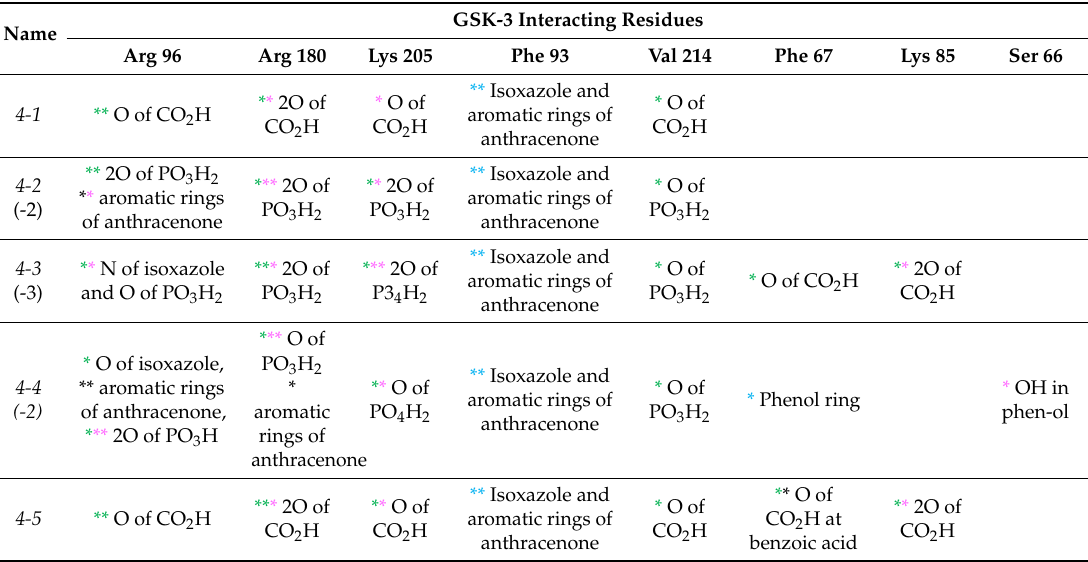
Figure 5. Docking new GSK-3 SCI molecules in GSK-3 substrate binding site. Docking models of GSK-3 β bound to 4-2 , 4-3 and 4-4 . Detailed interactions are also summarized in Table 2. Like 3-8 and the other leading hits, the new molecules interacted with the GSK-3 phosphate-binding pocket, Phe 93 and Val 214. 4-3 and 4-4 showed additional interactions with Phe 67, Ly 85 ( 4-3 ), or, Ser 66 ( 4-4 ). Interactions were analyzed by the Maestro software. Table 2. GSK-3 interactions with newly designed SCI compounds. The number of interactions (*), type of interaction, and atom / substructure involved are listed for each GSK-3 residue. Green, H-bond, blue π – π stacking, black, cation– π , pink salt bridge. Ionic charges of compounds are